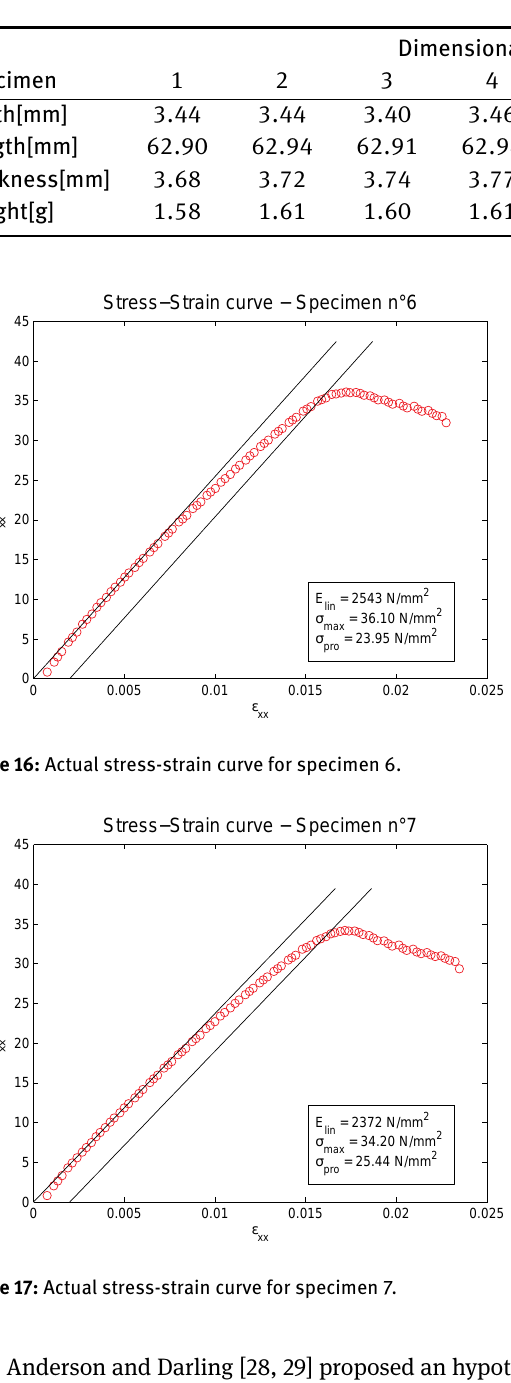
Table 2: Dimensional experimental data for the ten specimens.